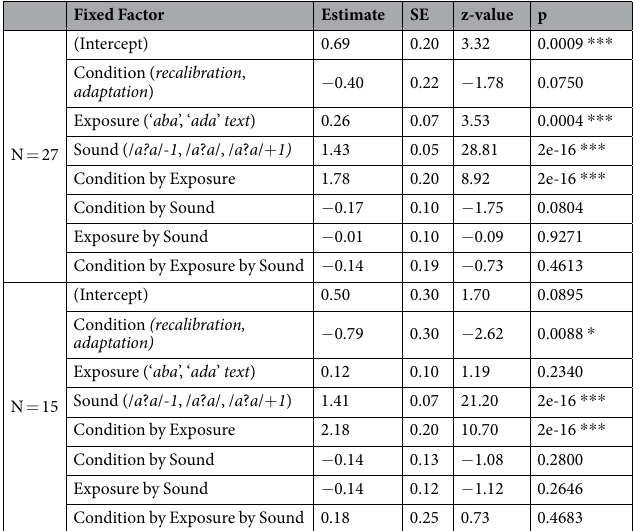
Table 1. Results psychophysical experiment. Fitted model: Response ~1 + Condition * Exposure * Sound + (1 + Condition + Condition:Exposure || Subject). Fixed effects correlations were below 0.18 (n = 27) or below 0.23 (n = 15). SE = standard error; *** p < 0.001; ** p < 0.01; * p < 0.05.